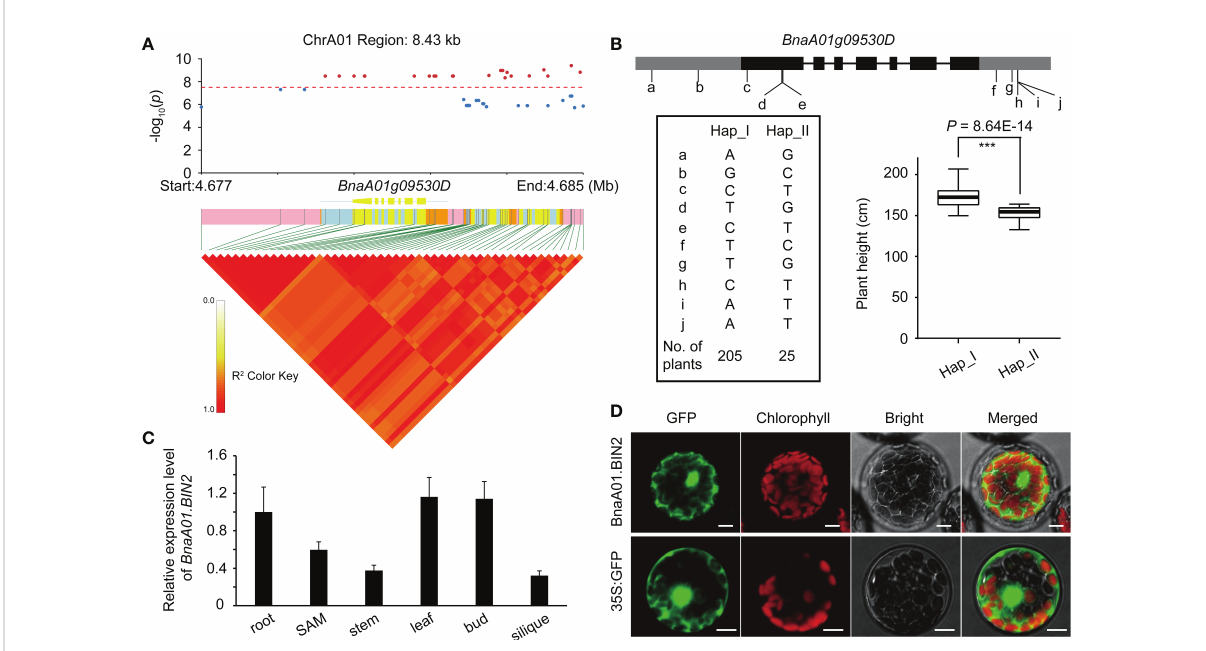
FIGURE 2 Integrated characteristic of BnA01.BIN2 . (A) LD block analysis of signi fi cant SNPs in BLUP based on MLM models. The threshold value is -log 10 (0.05/SNPs number). (B) Gene structure of BnaA01.BIN2 and haplotype analysis. (C) Subcellular localization of BnaA01.BIN2 in Arabidopsis protoplasts. Green fl uorescence, GFP; red fl uorescence, chloroplast auto fl uorescence; Merged, merged images of all channels. Bar = 10 m m. (D) Expression pattern of BnaA01.BIN2